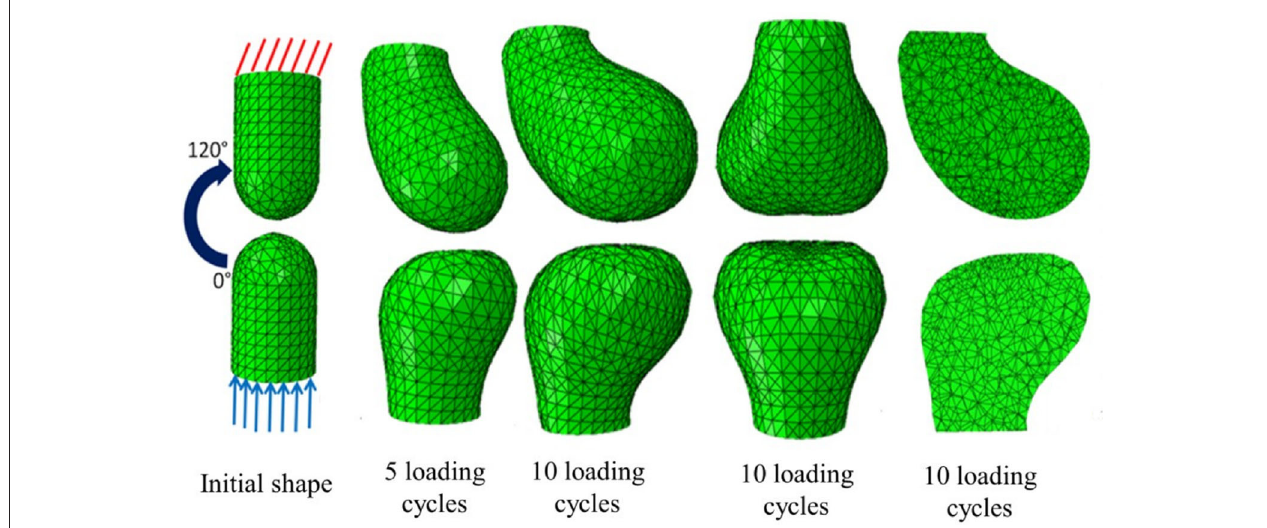
FIGURE 3 | Passive mechanical shaping of bone precursors. Reproduced with permission from Giorgi (2015) Mechanobiological predictions of fetal joint morphogenesis (Figures 3–25). Single plane motion from 0 to 120 degrees mimicking a hinge movement; the top phalange acquired a more rounded convex profile whereas the bottom phalange acquired a flatter